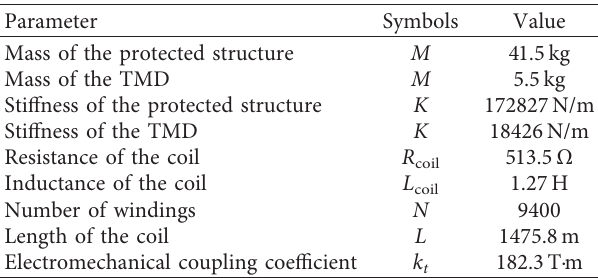
Table 2: Parameters of the 2-DOF TMD model.